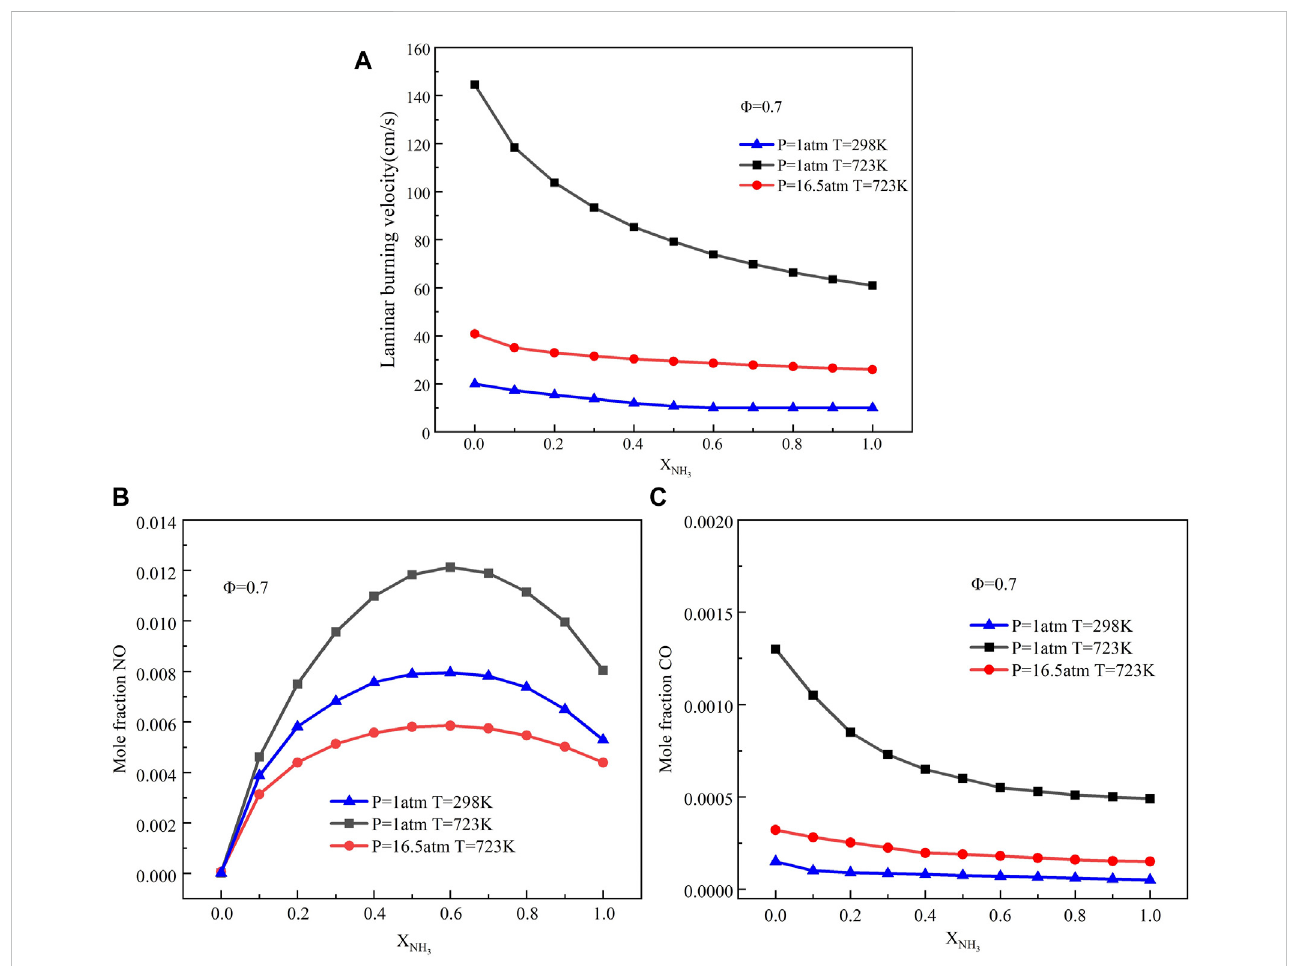
FIGURE 4 Variations of LBV, NO, and CO with ammonia content at different initial temperatures and initial pressures: (A) LBV; (B) NO emission; (C) CO